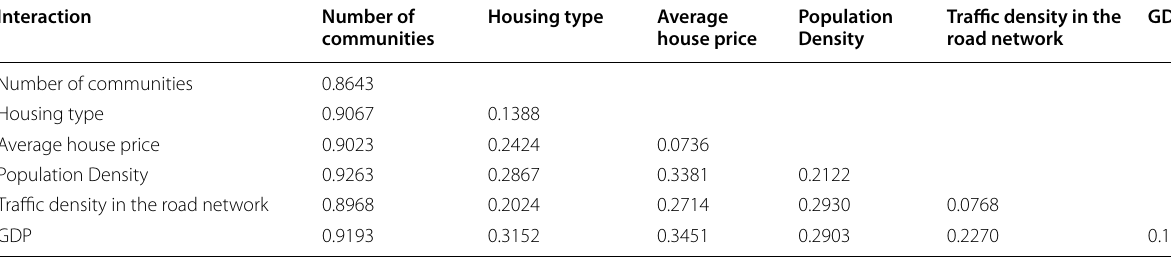
Table 3 Results of the interaction detector